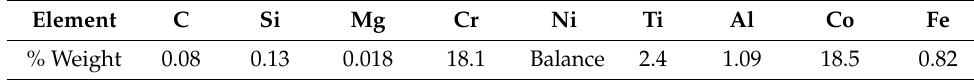
Table 1. Chemical composition of Nimonic-90